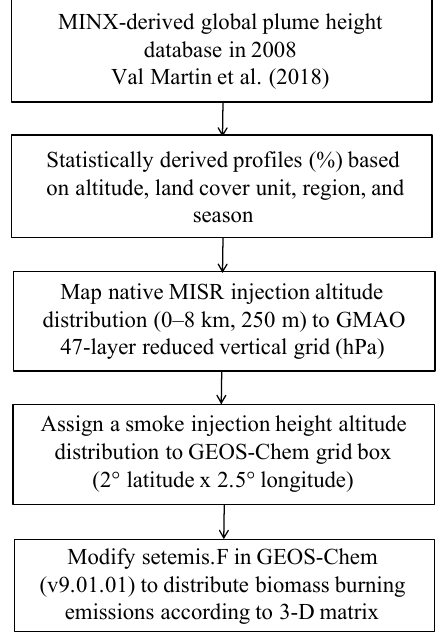
Figure 1. Overview of the implementation of an observationally based scheme to inject biomass burning emissions within GEOS-